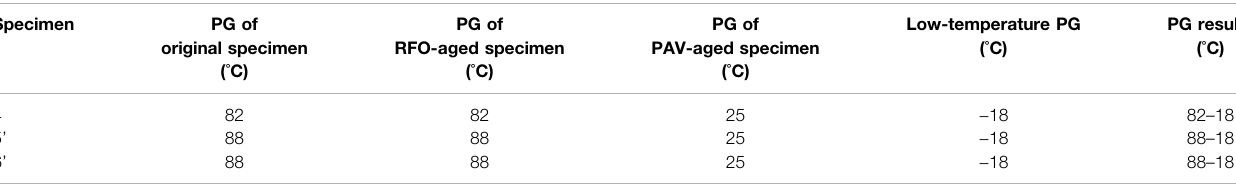
TABLE 5 | PG of binder before and after